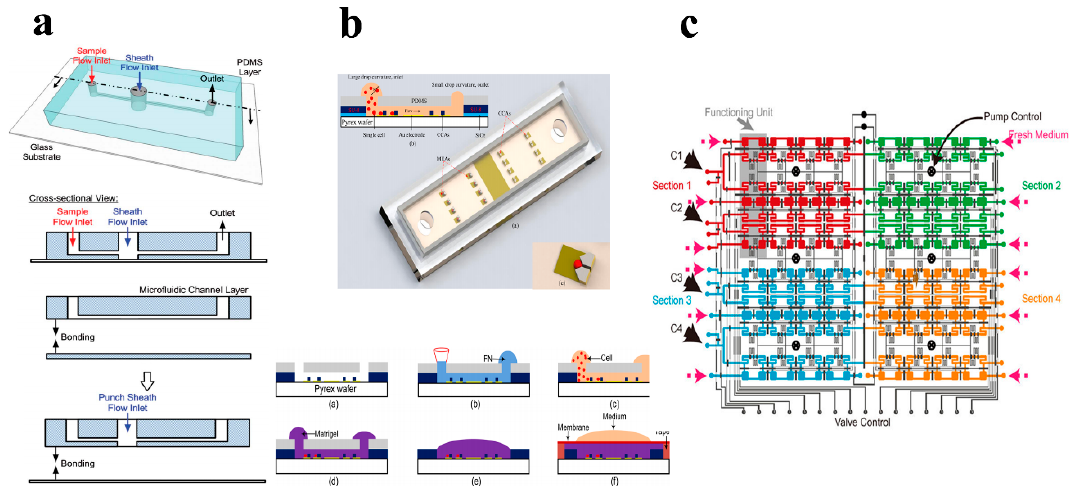
Figure 4. ( a ) Schematic of a PDMS-based flow cytometry microfluidic device and its fabrication process [94]. Reproduced with permission from Royal Society of Chemistry; published by Royal Society of Chemistry, 2012. ( b ) Schematic of an on-chip biochemical sensor [107]. Reproduced with permission from Tien Anh Nguyen; et al. Analytical Chemistry; published by American Chemical Society, 2013. ( c ) The layout of a very complicated microfluidic device for whole cell assay [108].